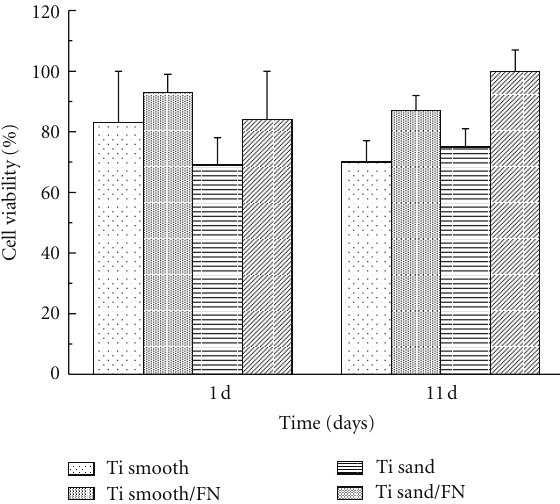
Figure 2: Cell viability determined by MTT assay.